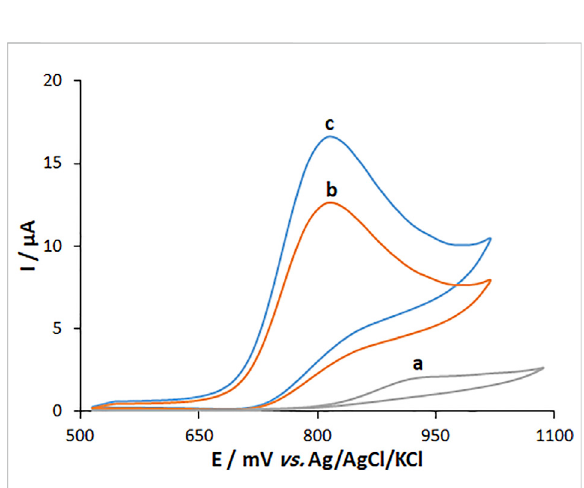
FIGURE 7 CVsof (A) BPGE, (B) MWCNT/PEGand (C)